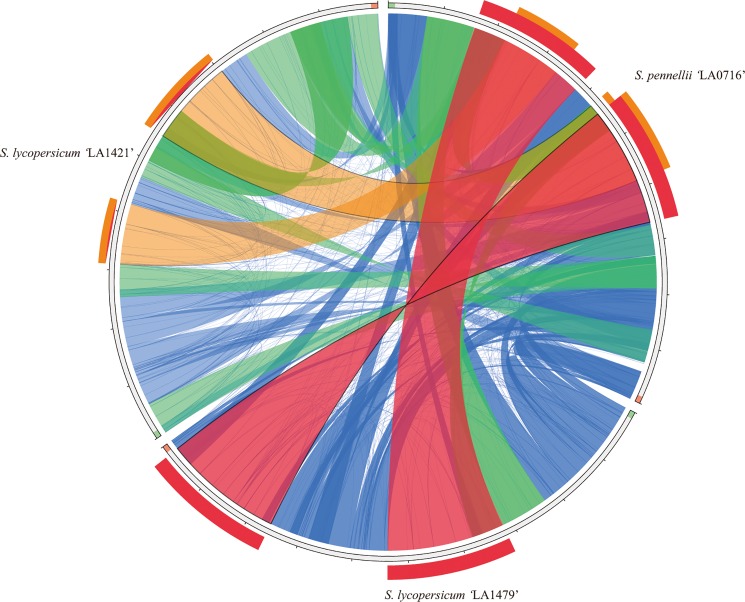
Map of rearrangements among the three tomato mitogenomes.Colors refer to the score/max bits core ratio, with blue ≤0.25, green ≤0.50, orange ≤0.75, and red >0.75.